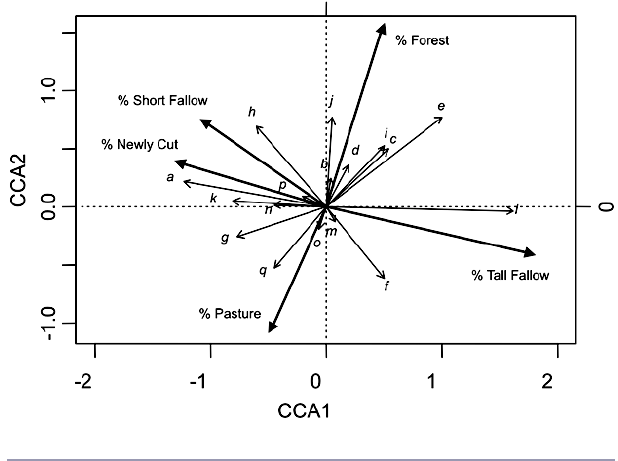
Fig. 4 . Biplot of canonical correspondence analysis between land cover (dependent variables) and social–cultural, economic, and political influences on land use (explanatory variables), as mentioned by interviewees. Influences are in italics, while percent land cover is represented by bold arrows. a = Availability of resources and labor. b = natural resource use by outsiders. c = encroaching frontier settlement. d = off-farm employment opportunities. e = population increase. f = potential income. g = presence of external markets. h =